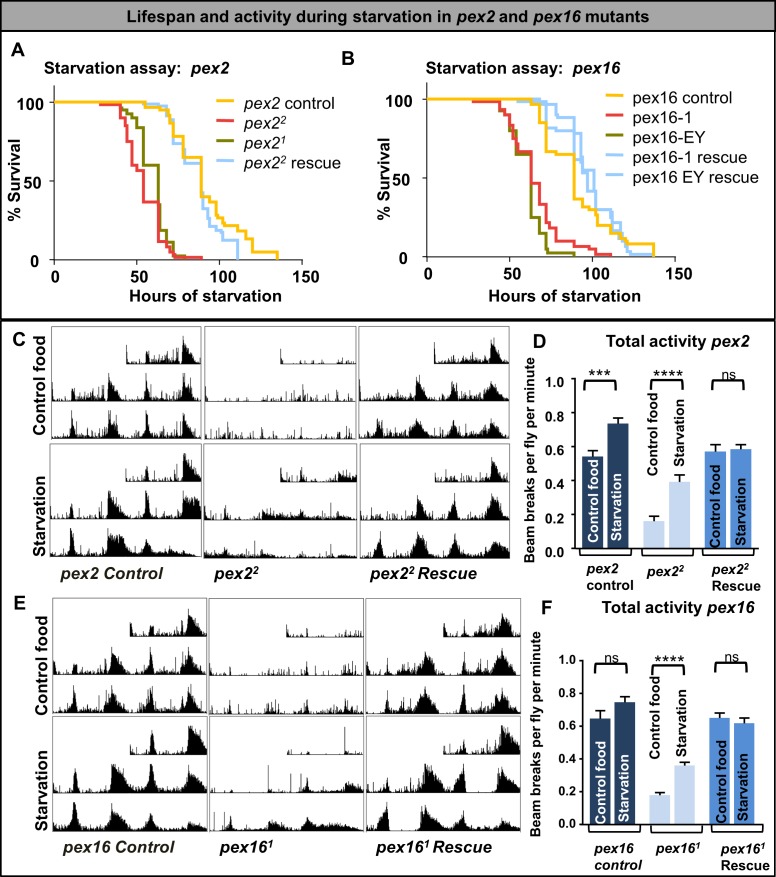
Lifespan and activity during starvation in pex2 and pex16 mutants.(A) Survival assay during starvation in pex2 mutant flies. Color codes show the genotypes with control flies (yellow)(n = 60), pex22 (red)(n = 60), and pex21 rescue (blue)(n = 80) and pex21,(brown)(n = 80). (B) Survival assay during starvation in pex16 mutant flies. Color codes show the genotypes with control flies (yellow)(n = 60), pex161 Rescue(n = 60), and pex16EY rescue (solid blue)(n = 60), and pex16EY (brown)(n = 40) and pex161,(red) (n = 60). (C) Actograms in the DAM assay in control and starvation conditions showing increased activity level particularly in the pex22 mutants. (D) Quantification of total activity in the DAM assay in control and starvation conditions (bars indicate SEM). (E) Actograms in the DAM assay in control and starvation conditions showing increased activity level particularly in the pex161 mutants. (F) Quantification of total activity in the DAM assay in control and starvation conditions (bars indicate SEM).